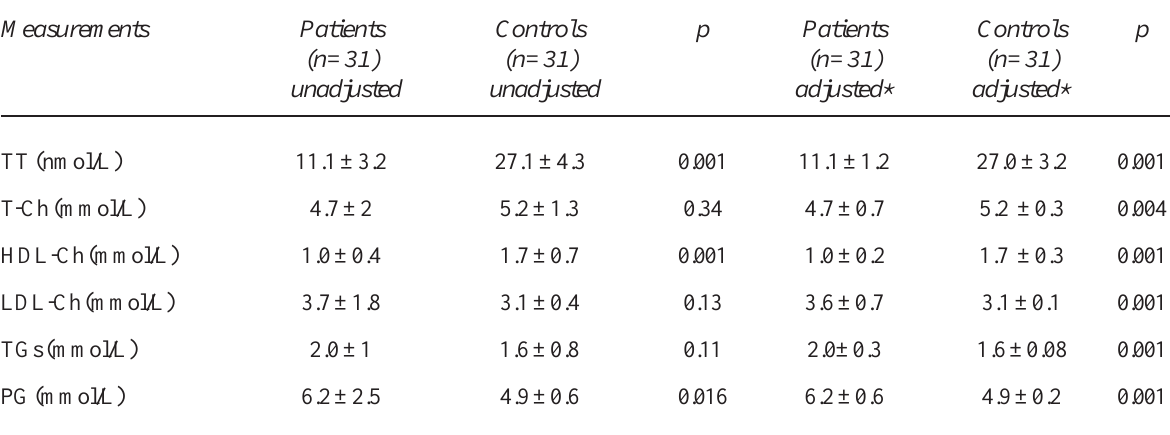
Table 2. Comparison of laboratory findings